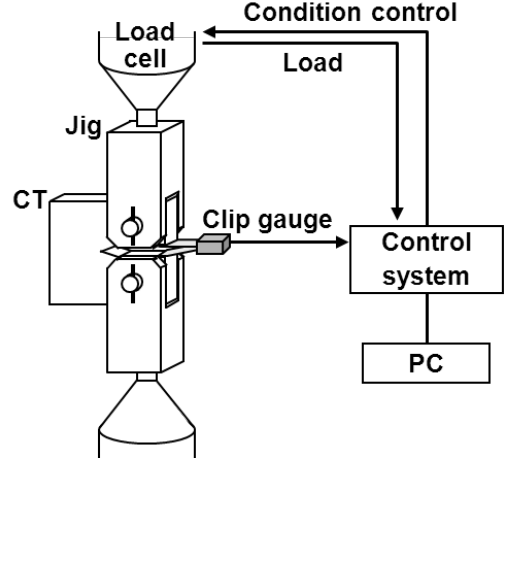
Figure 5. Fatigue crack growth test jig and equipment